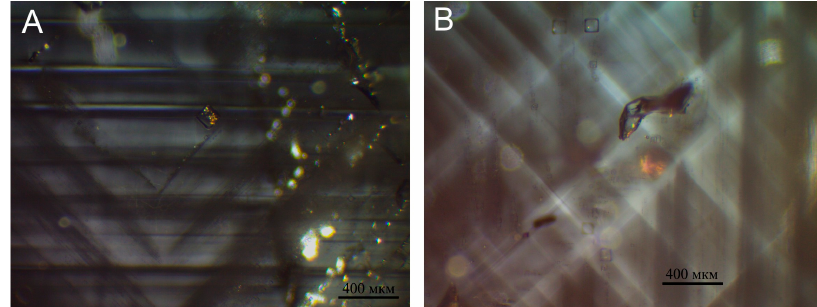
Figure 12. Stress lines in halite, XPL, sample No.